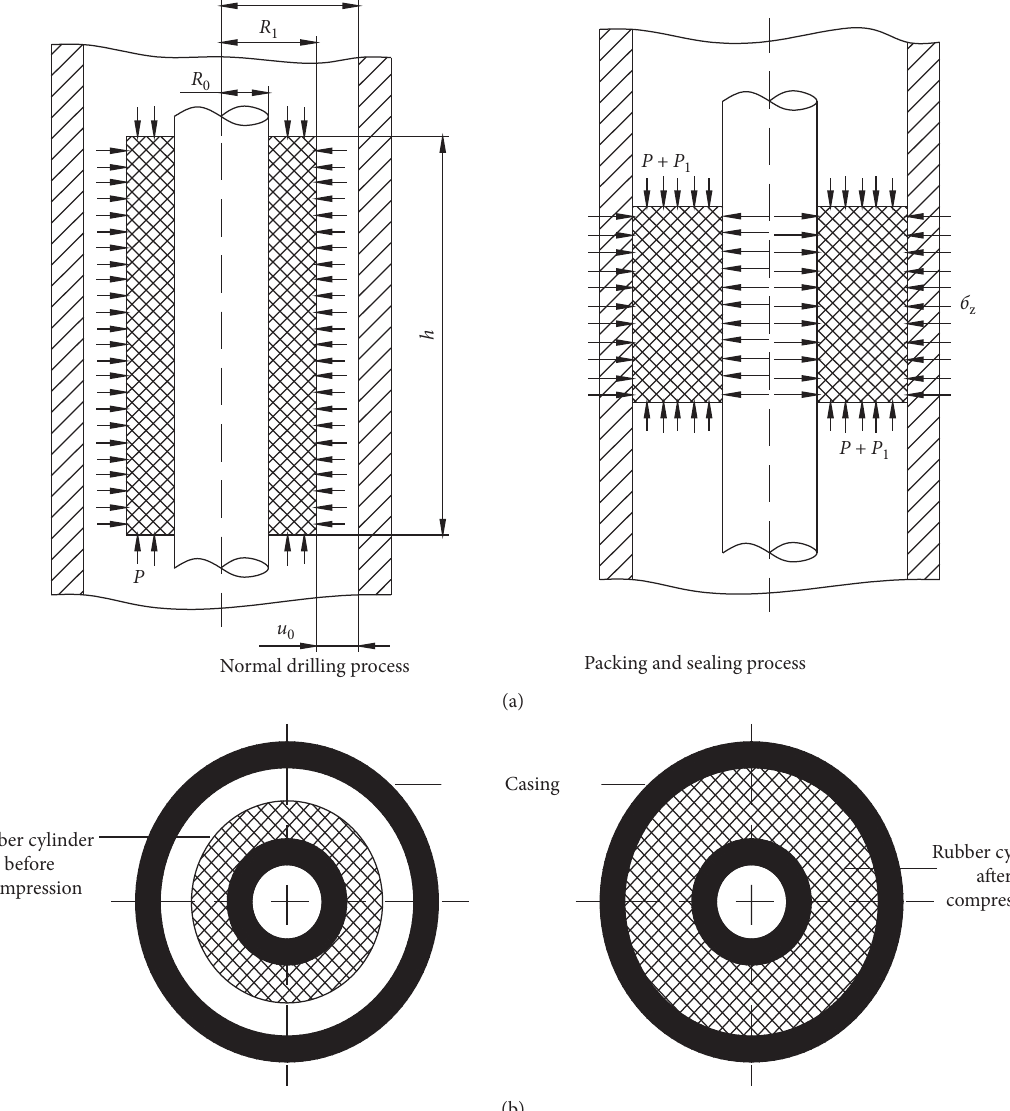
Figure 4: Force sketch and cross section of the rubber cylinder. (a) Force sketch of the rubber cylinder. (b) The rubber cylinder before and after